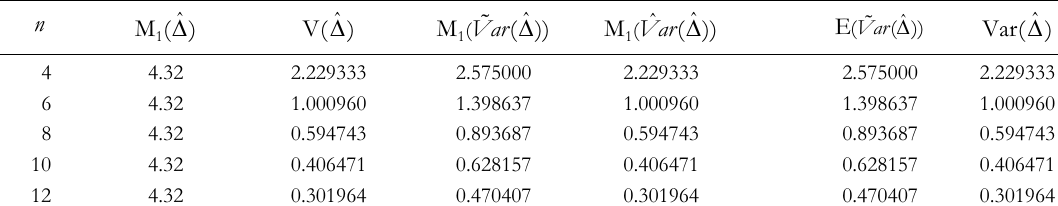
Data for the estimation of ˆ (cid:39) and )ˆ (Var (cid:39) for f.p.2, obtained by generation of the whole sample space, compared with the theoretical values of E ˆ ( ( )) Var (cid:39) (cid:4)